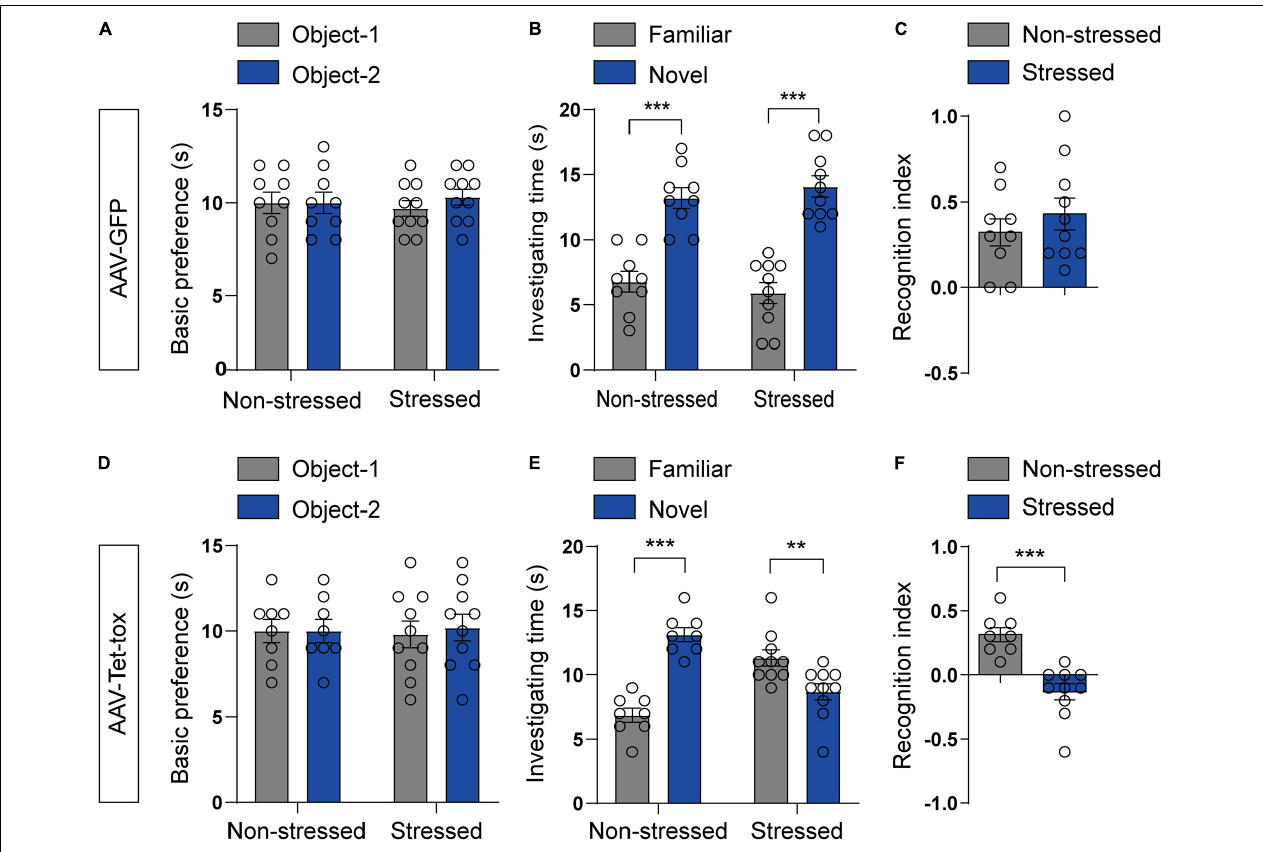
FIGURE 4 | Effect of ZI silencing on spatial cognitive ability. (A,D) The basic preference of mice for two identical objects were examined before training. The mice in all groups did not exhibit an innate preference for the two identical objects. The two-tailed paired t -test was used to compare the preference score of mice for object-1 and object-2. (B,E) The investigating time of mice for two identical objects were examined after training. The non-stressed mice spent more investigating time on the novel location object than that on the familiar location object, whereas the stressed mice spent more investigating time on the novel location object only in AAV-GFP group, and showed the opposite phenotype in AAV-Tet-tox group. Two-way ANOVA with bonferroni post hoc test was used to compare the investigating time for the novel and familiar location object. (C,F) The RI of two identical objects by mice was recorded after training. The stressed mice showed similar RI to the non-stressed mice in AAV-GFP group, while the RI was significantly decreased in stressed mice compared to the non-stressed mice in AAV-Tet-tox group. The two-tailed unpaired t -test was used to compare the RI between non-stressed and stressed mice. ** p < 0.01, *** p <